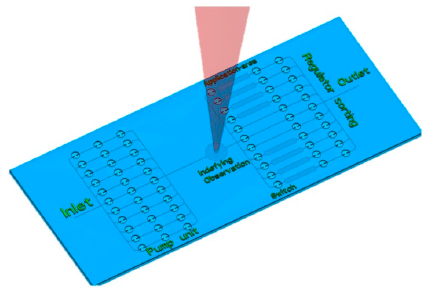
Figure 1. Conceptual illustration of a large-scale integrated device with all-glass monolithic membrane valves. The many valves have numerous possible functions, such as pumping, flow switching, flow rate regulation, and particle or cell sorting.